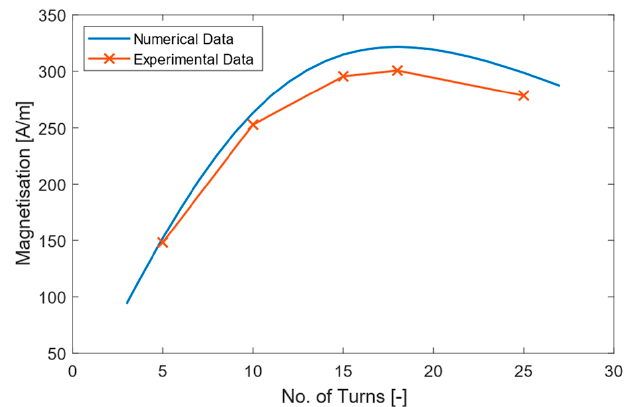
Figure 4. Numerical model magnetisation. Number of turns curve, blue, with the experimental data points for 5, 10, 15, 18 and 25 turns shown, orange.